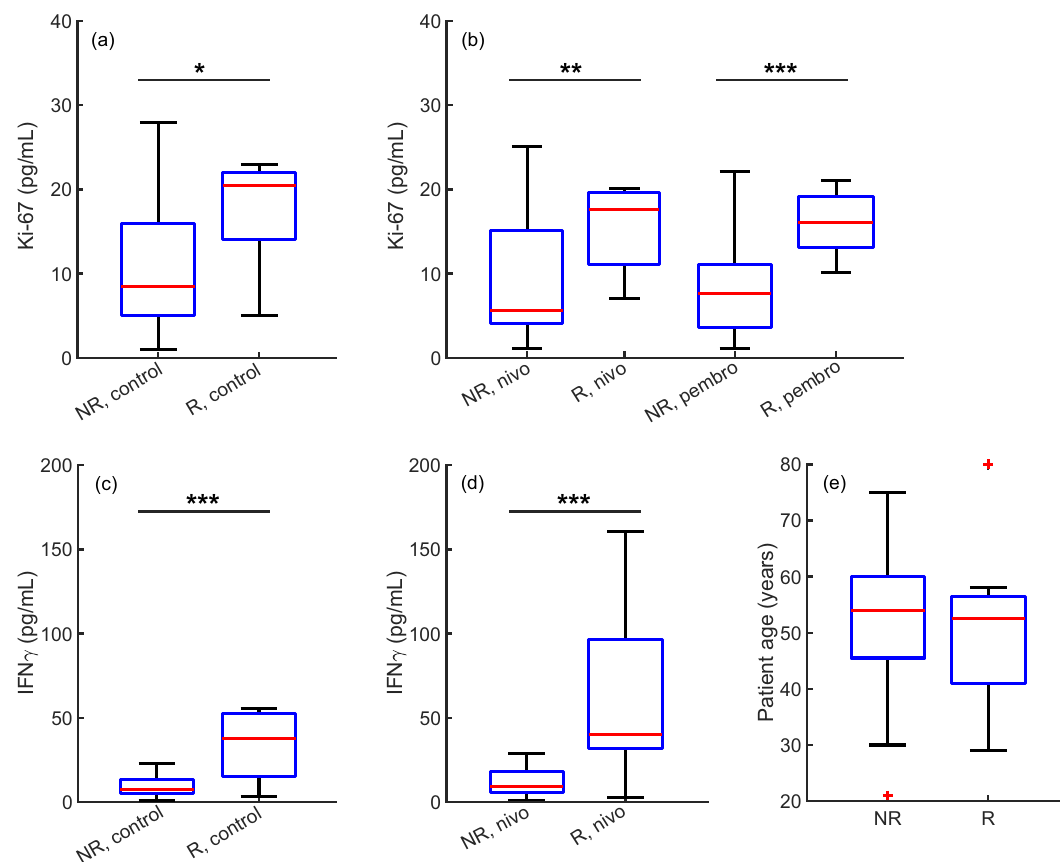
Fig. 5 Statistically signi fi cant differences between patients classi fi ed as “ responders ” (R) and “ non-responders ” (NR) under vehicle control, nivolumab (nivo) treatment, and pembrolizumab (pembro) treatment conditions. a , b Average ex-vivo Ki-67 expression. c , d Average ex-vivo IFN γ expression. * p < 0.02, ** p < 0.05, *** p < 0.01. In a – d , outliers were removed for visual clarity. There were no statistically signi fi cant age differences between the responder and non-responder groups ( e